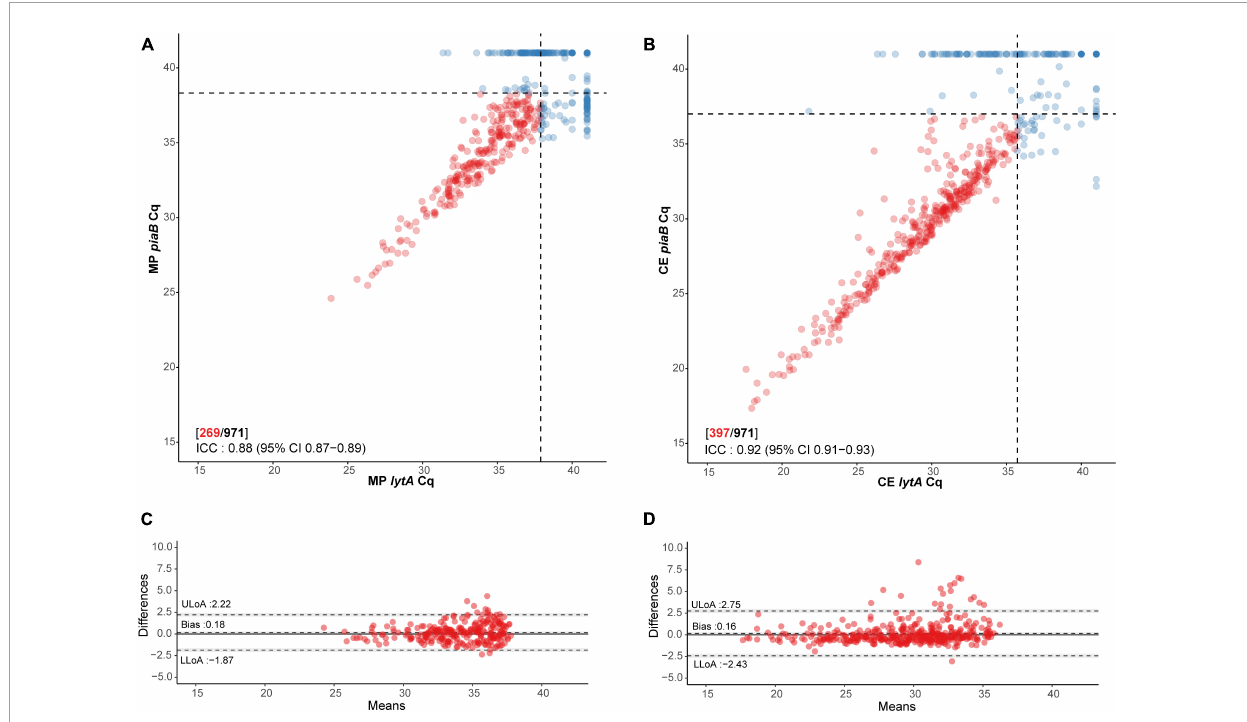
FIGURE1 Scatter plot illustrating extent of agreement between piaB and lytA in (A) minimally processed and (B) culture-enriched saliva samples and Bland–Altman plots ( C,D , respectively) displaying extent of agreement and bias among samples with C q s < 40 for piaB and lytA . Dots colored in red depict samples with C q s < 40 for piaB and lytA , remaining samples are colored in blue. Black dashed lines in scatter plots indicate data-driven thresholds. In Bland–Altman plots black dashed lines indicate the upper (ULoA) and lower limit of agreement (LLoA) and mean difference (bias). Shaded areas indicate 95% confidence interval. The solid black line indicates the line of equality (no